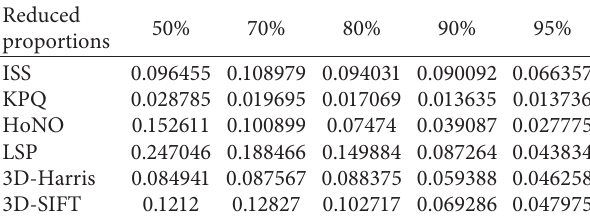
of the key point density